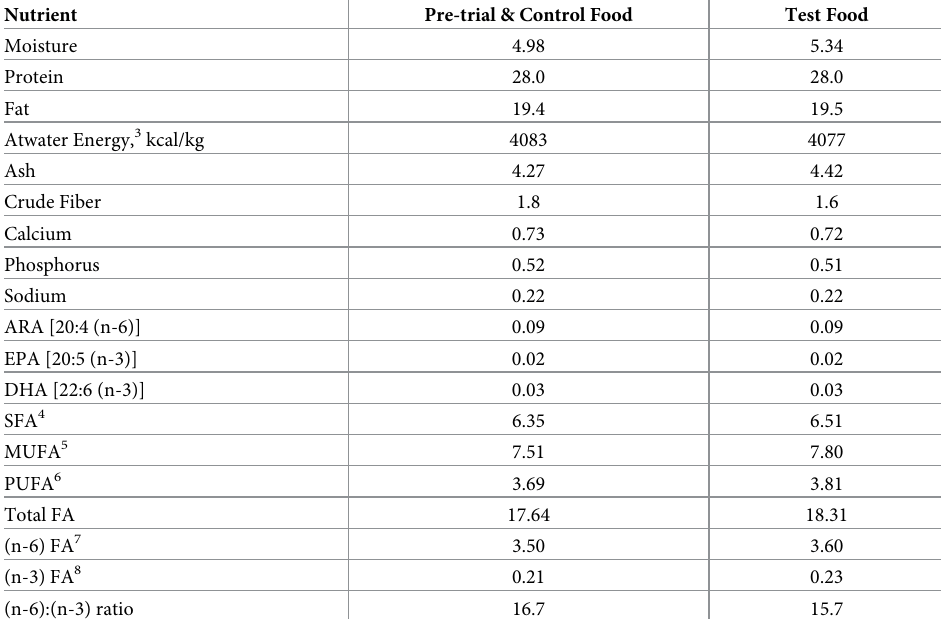
Table 1. Composition of pre-trial (Control food 1 ) and test food 2 . Nutrient Pre-trial & Control Food Test Food Moisture